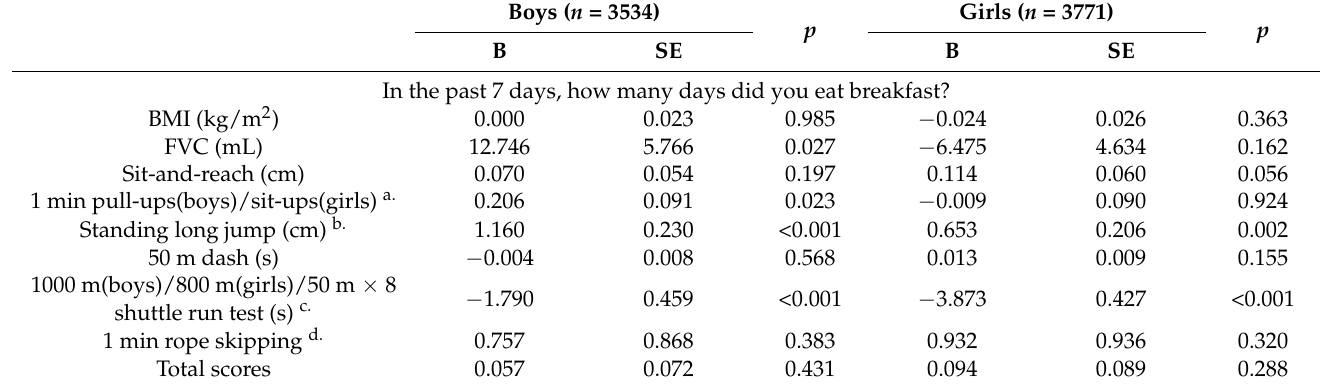
Table 3. Association between frequency of breakfast consumption and physical fitness in children and adolescents.